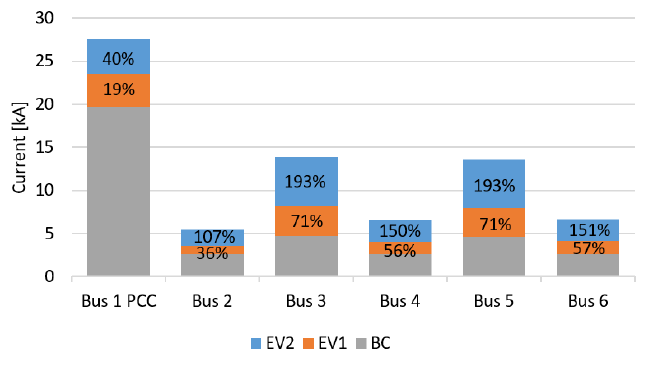
Figure 7. Short-circuit scenarios without